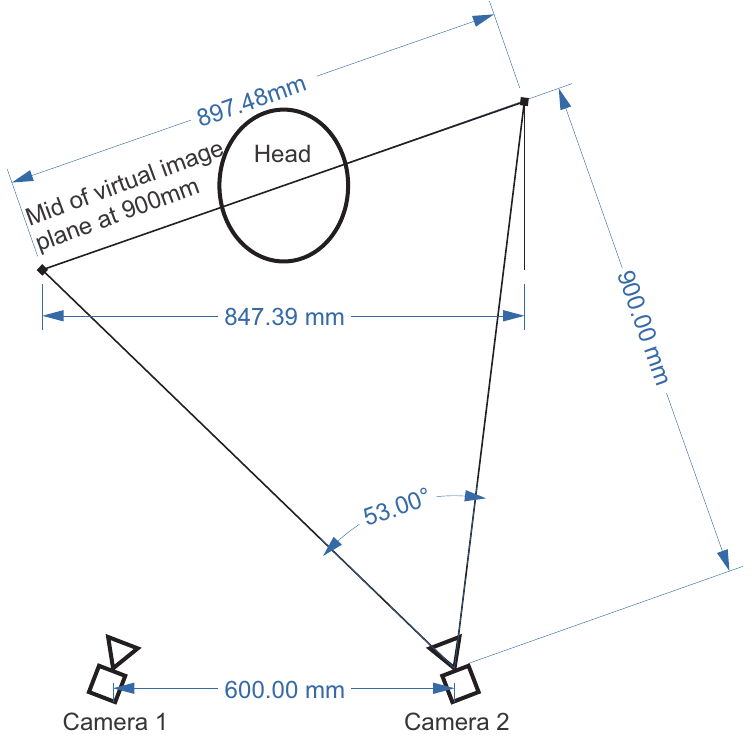
Figure 2. Simplified top view of the camera setup. Two infrared cameras are oriented in the direction of the